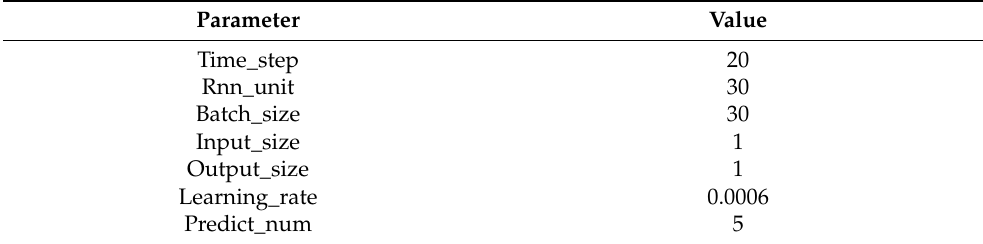
Table 1. Setting of LSTM